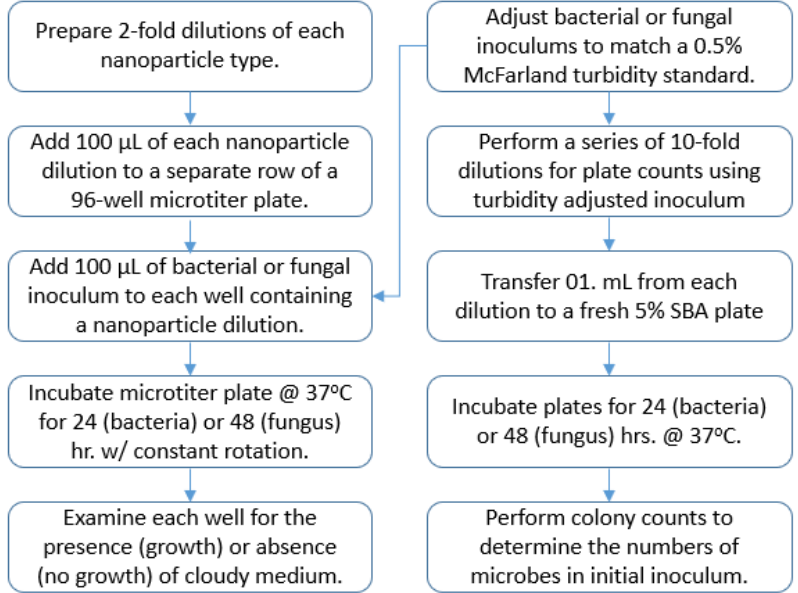
Figure 1. Testing schematic. Simplified diagram outlining general steps accomplished during the testing process.